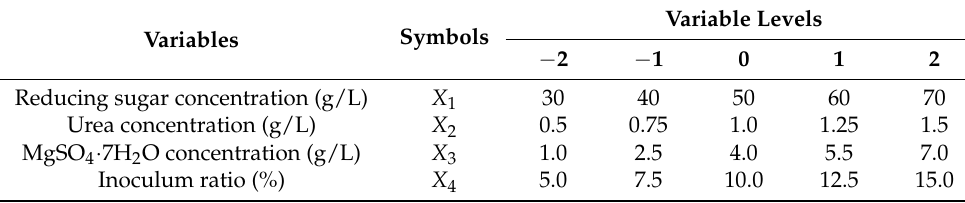
Table 1. Input variables for RSM